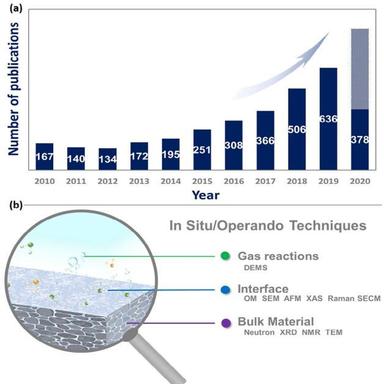
(a) The cartogram of published papers related to in-situ/operando techniques within the field of rechargeable batteries in recent years. Data were collected from Web of Science in September 2020; (b) summary of the insitu/operando techniques introduced in this review.